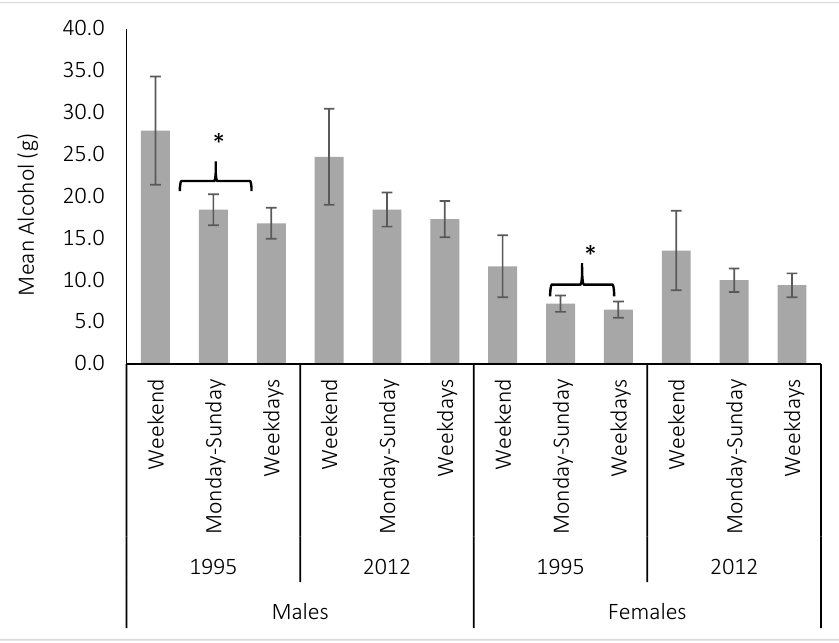
Figure 2. Comparison of per-capita pure alcohol (g) intake (mean 95% Confidence Interval) for weekends (Friday and Saturday), weekdays (Sunday–Thursday) and the whole week (Monday–Sunday) for Australian adults aged 18 years and over in the National Nutrition Survey, 1995 and National Nutrition and Physical Activity Survey, NNPAS-2011/12. * p = 0.02 for men and p = 0.04 for women. Survey specific weights were applied.